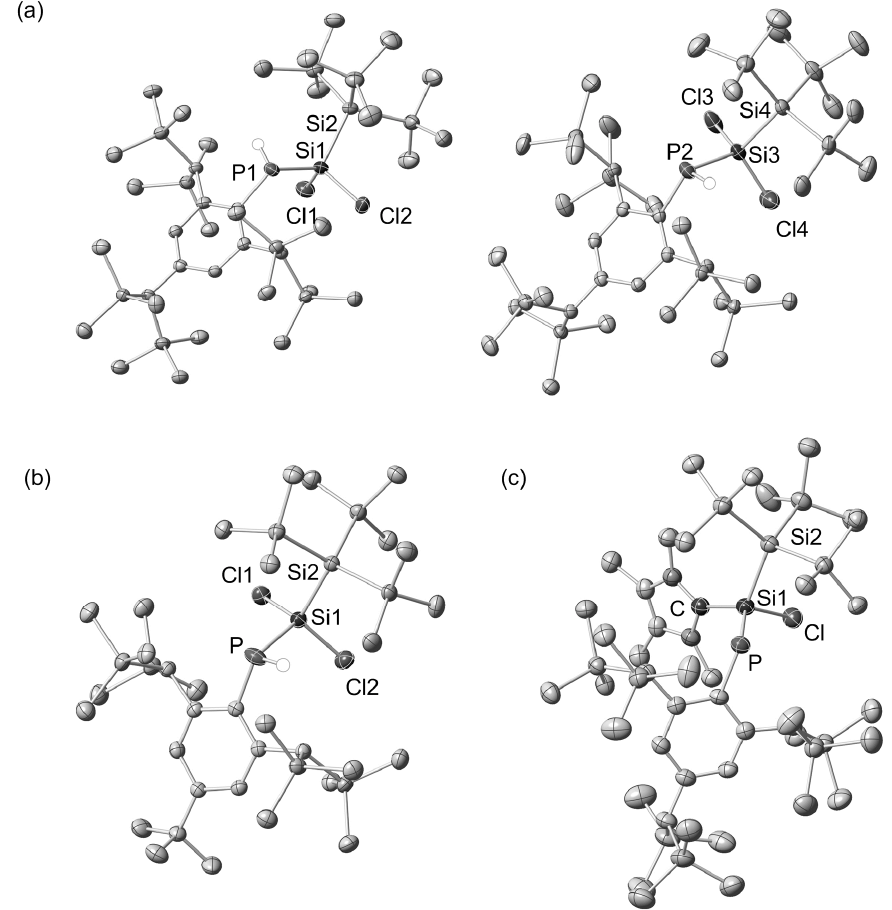
Figure 1. Molecular structures of ( a ) 10a (two independent molecules in the unit cell); ( b ) 10b ; and ( c ) 11a with atomic displacement parameters set at 50% probability. All hydrogen atoms other than those at the P atoms are omitted for clarity and only selected atoms are labeled. Selected bond lengths (Å)